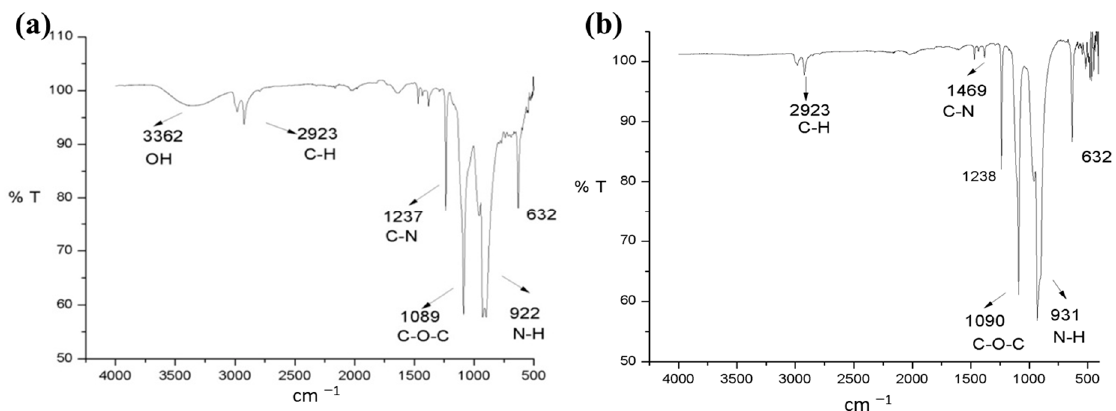
Figure 5. FTIR spectra of the P. koreensis /alginate beads system after the adsorption at ( a ) 32 h and ( b ) 48 h.